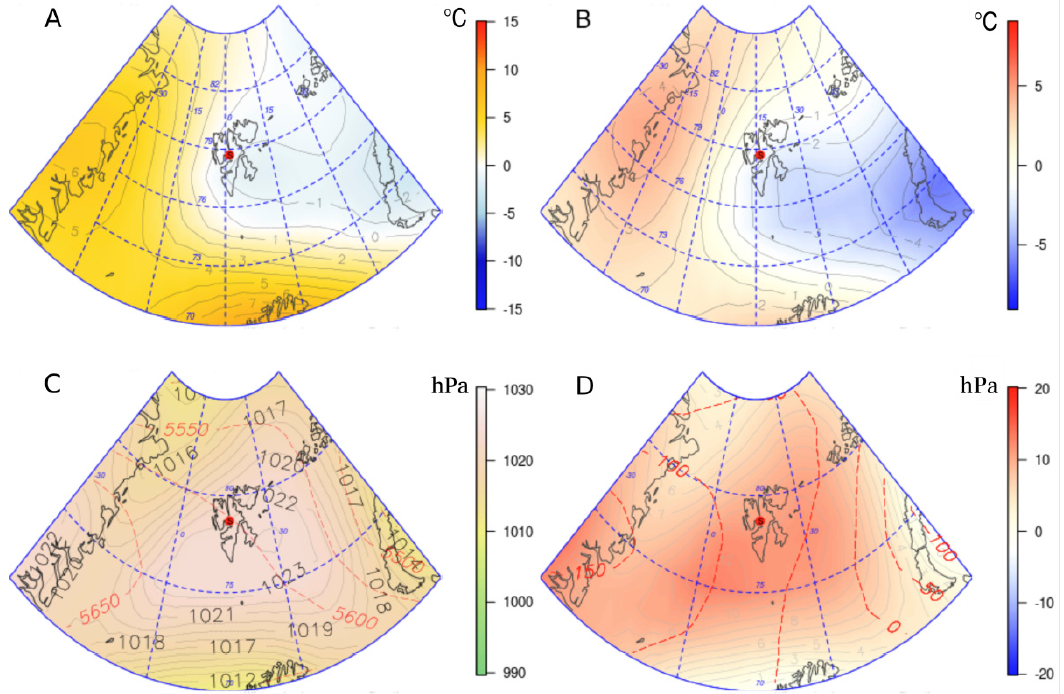
Figure 6. Air temperature at an altitude of 850 hPa (T850) (°C)—grey solid line ( A ) and its anomalies ( B ) and the average daily sea-level pressure distribution (SLP) (hPa)—grey solid line and geopotential height of 500 hPa (m)—red dotted line ( C ) and its anomalies ( D ) for 27 July 2016. The red point shows the research area.